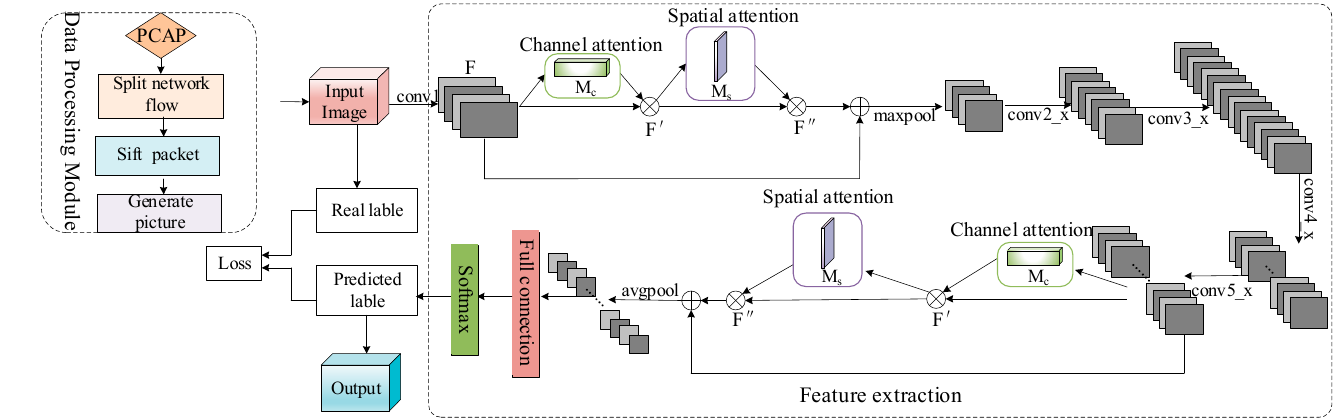
Figure 1. Overview of network framework.